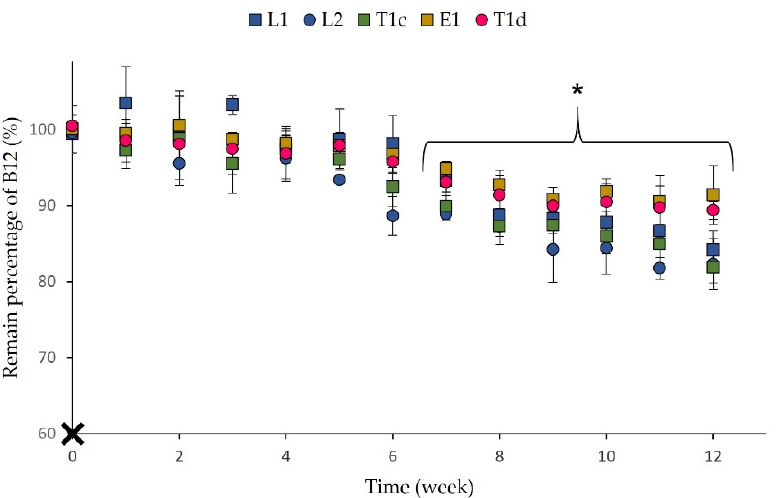
Figure 5. ( a ) Vesicle size over 2 months of storage (4 °C); ( b ) PDI over 2 months of storage (4 °C). All results are expressed as mean ± SD ( n = 3). * means statistically significant differences when compared to the initial values ( p < 0.05) using one- way ANOVA followed by Tukey’s multiple comparison test.